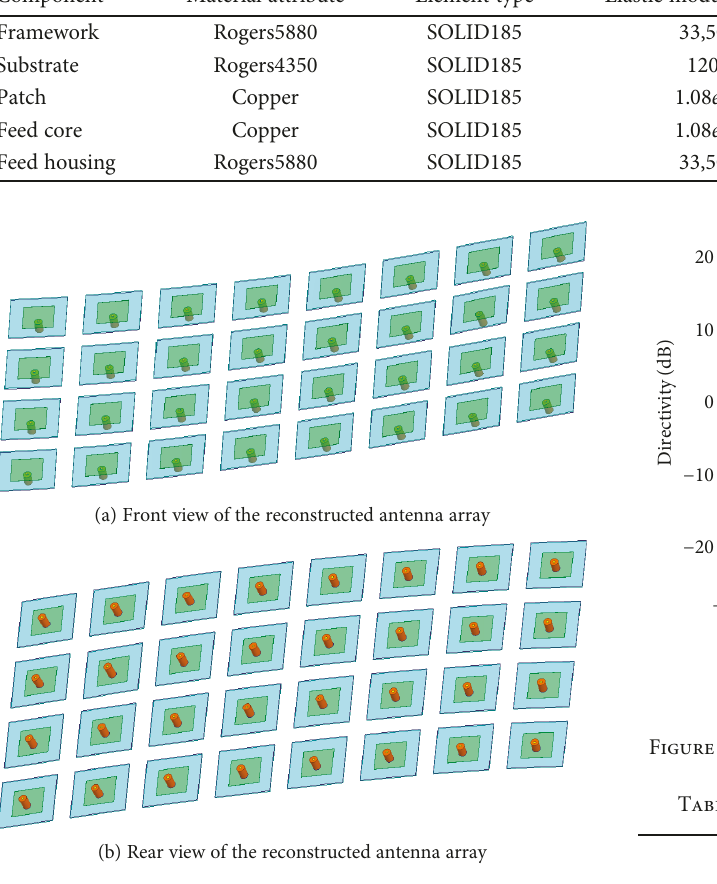
Figure 14: Reconstructed antenna array model.